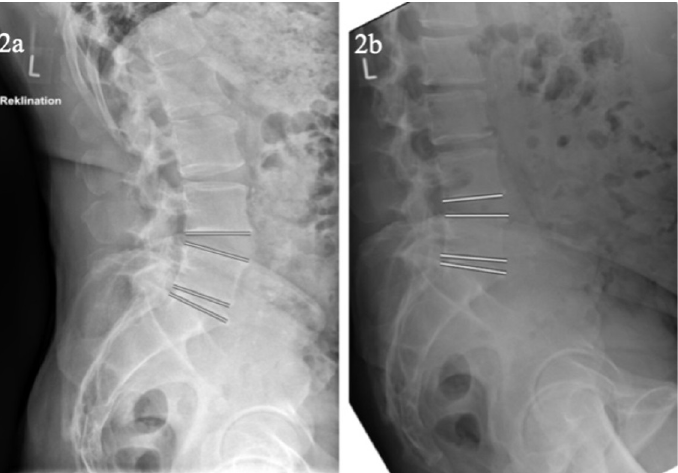
Fig 2. Example of a patient with reduced mobility in transitional segment L5/S1 and compensatory enhanced mobility in the cranial adjacent segment. a. depicts the dorsal trunk extension with increased segmental and lumbar lordosis, which results mostly of the cranially adjacent segment to the transitional segment L5/S1 in this participant. b. depicts the ventral trunk flexion with reduced segmental and lumbar